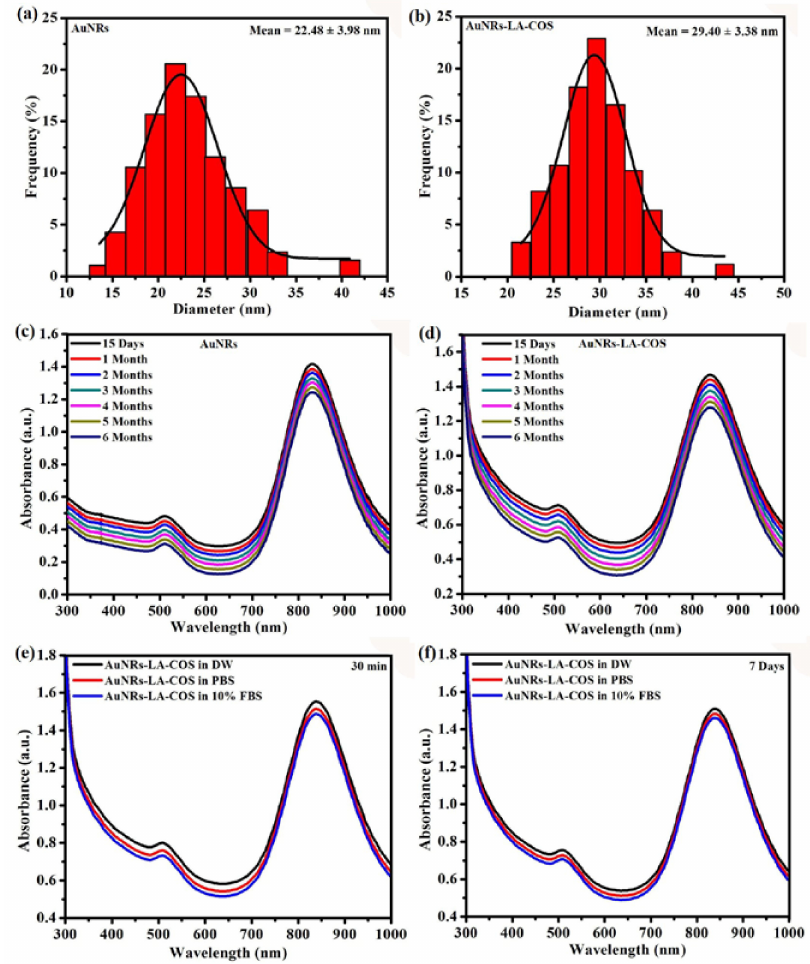
Figure 2. DLS results of AuNRs ( a ) and AuNRs-LA-COS ( b ). UV-Vis-NIR absorbance spectra of AuNRs ( c ) and AuNRs-LA-COS ( d ) of six months stability study. UV-Vis-NIR absorbance spectra of AuNRs-LA-COS of dispersion stability in DW, PBS, and DMEM supplemented with 10% fetal bovine serum (FBS) for 30 min ( e ) and 7 days ( f